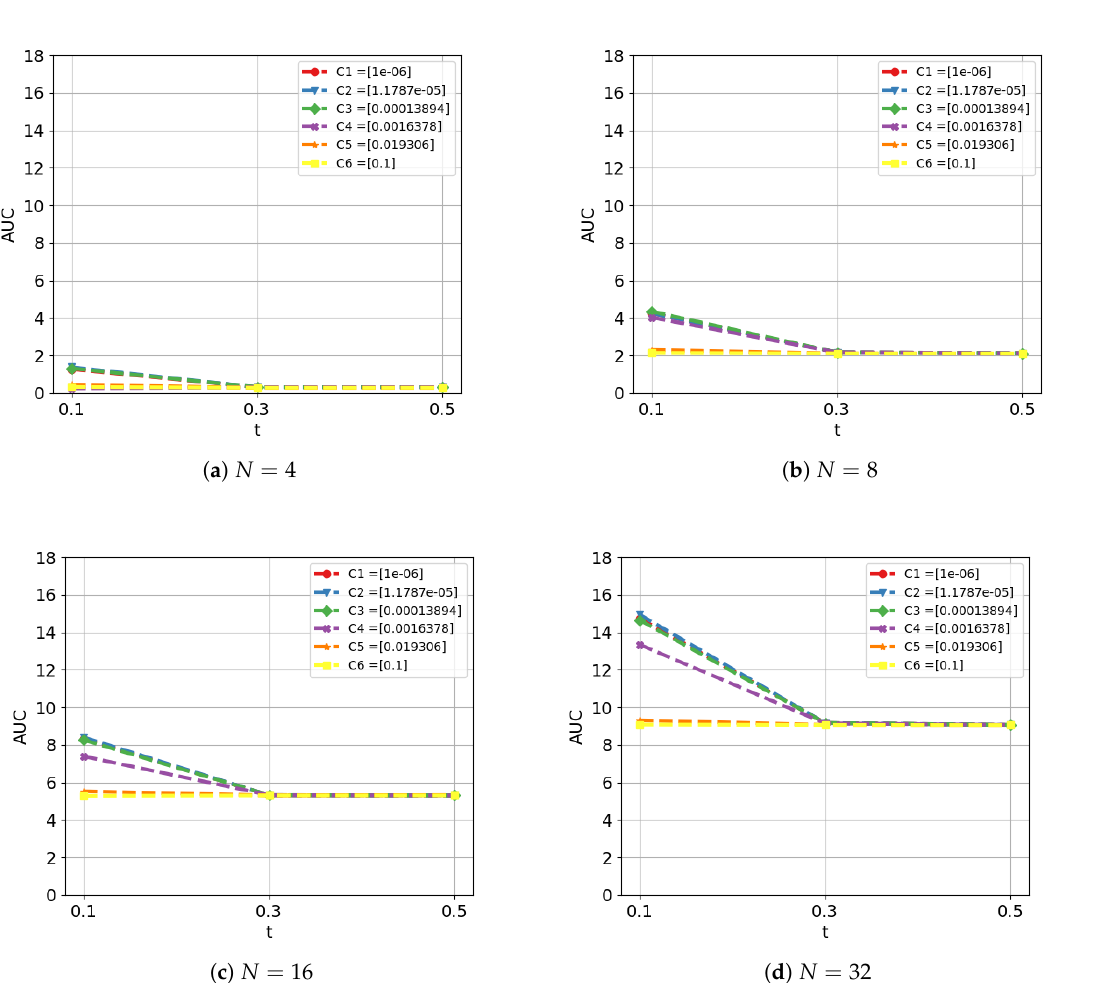
Figure 4. Ablation study on ActivityNet dataset. Performance in terms of AUC of the AR-AN curve when varying the parameters N , t and C . Basic configuration: linear kernel for the SVC module and no rank-pooling